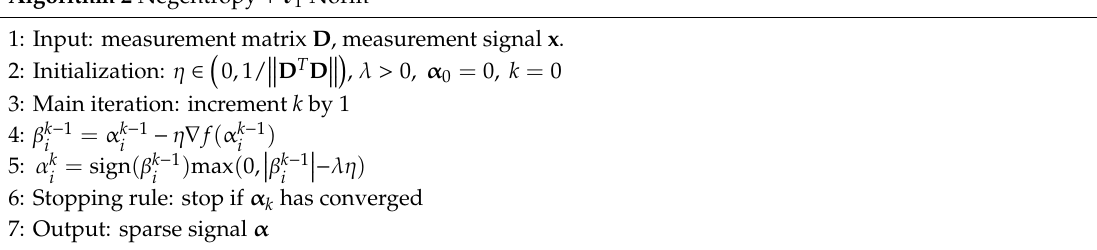
Algorithm 2 Negentropy + (cid:96) 1 Norm